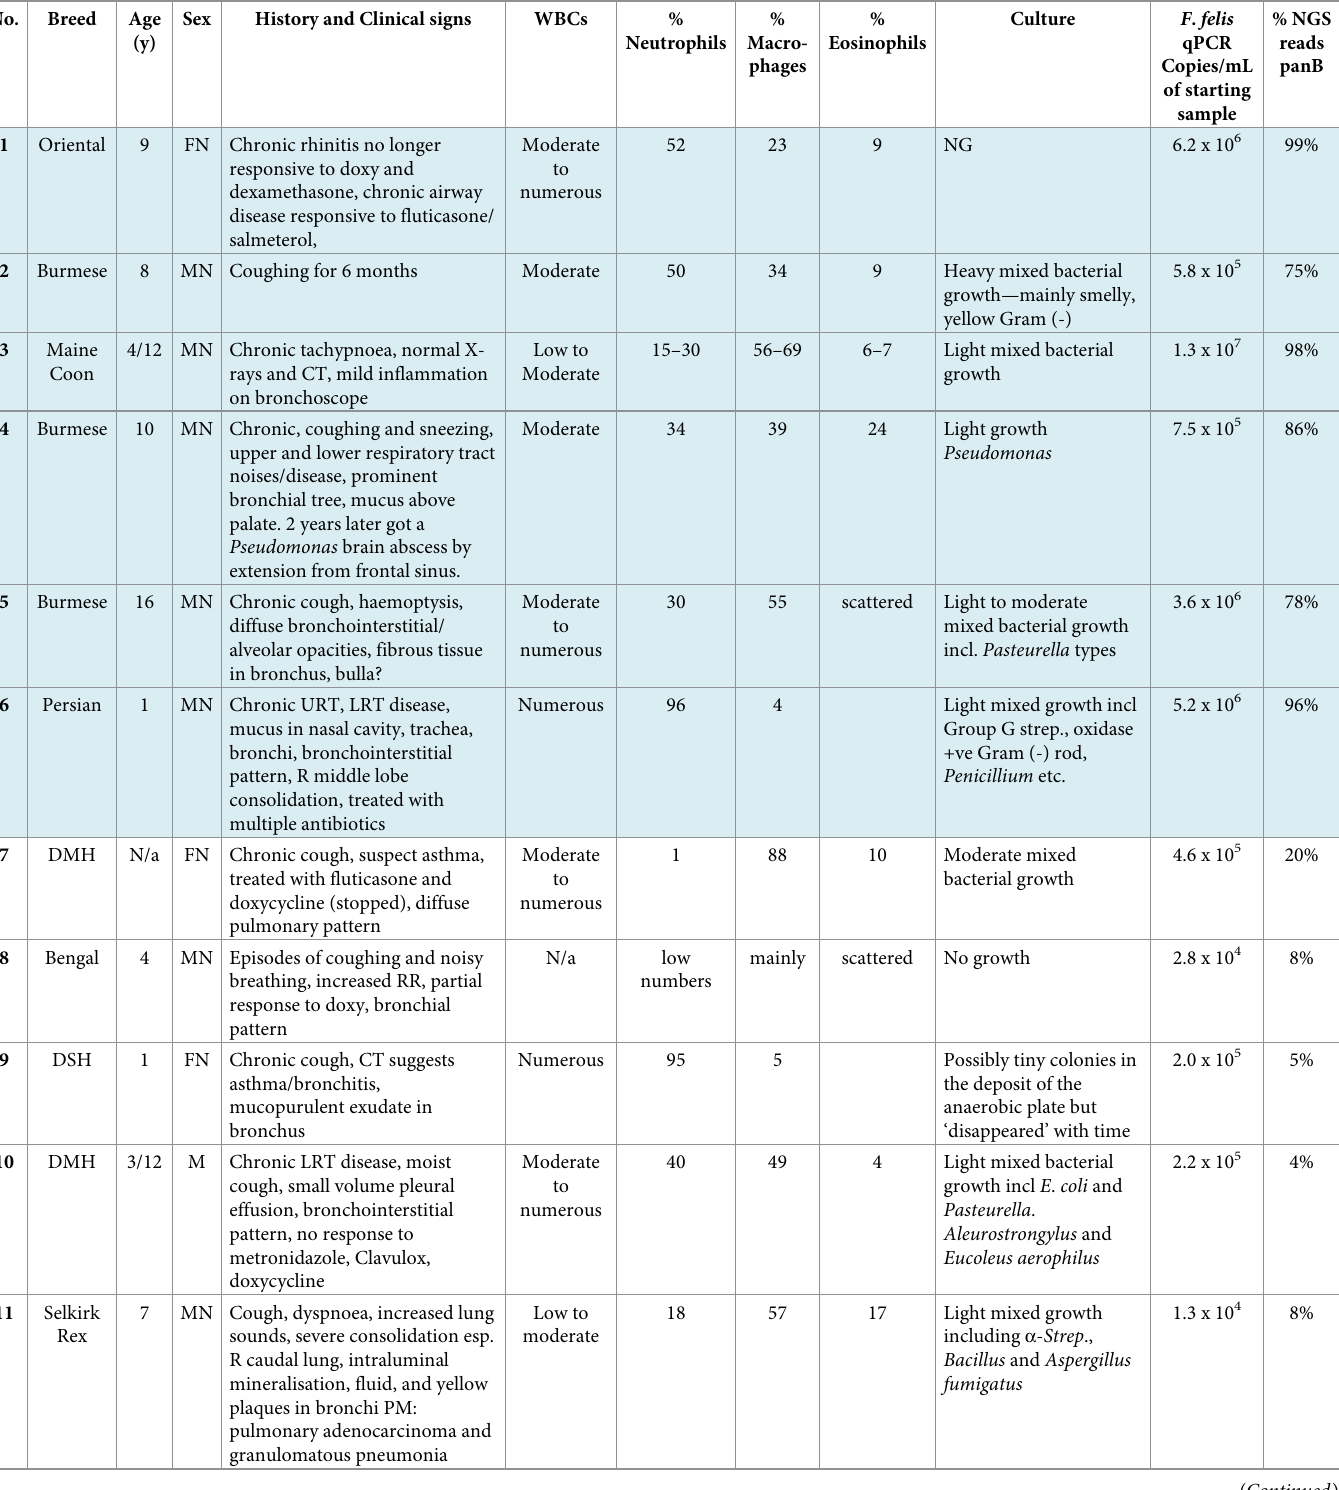
Table 1. BAL samples of 13 cats with bronchial disease from Australia. No.